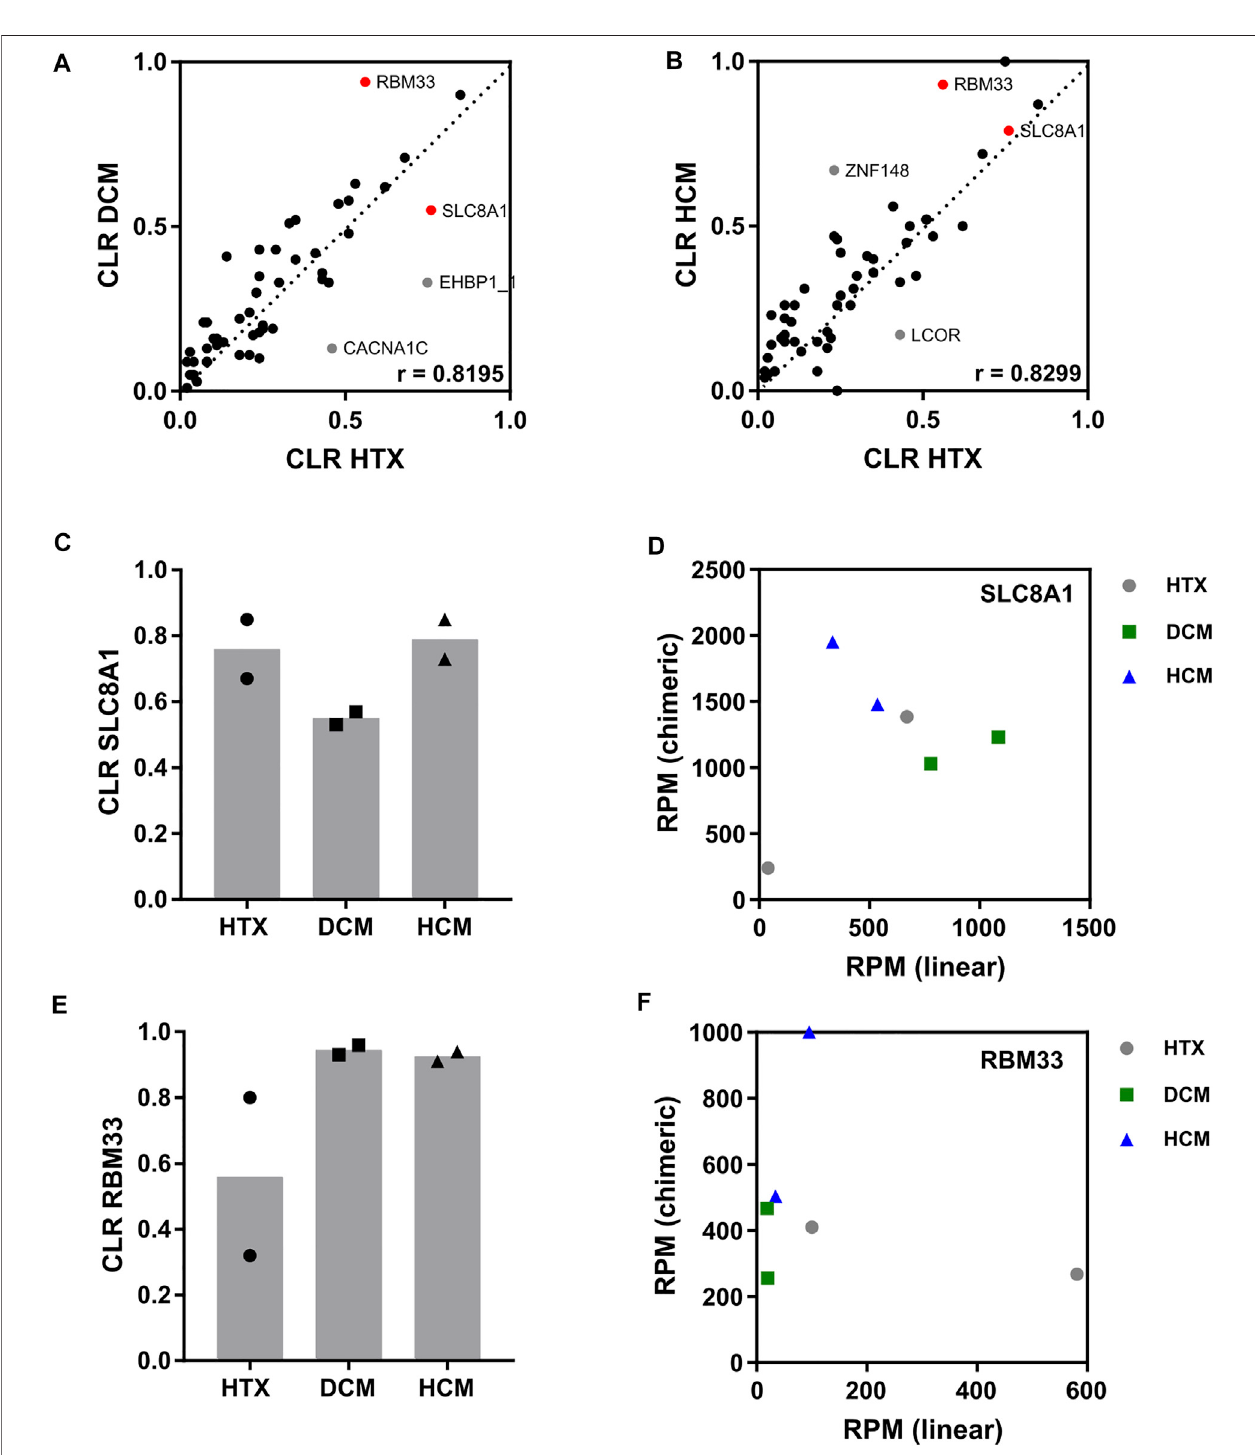
FIGURE 4 | Identi fi cation of deregulated circRNAs in cardiomyopathies. Samples from patients diagnosed with DCM, HCM, or HTX as control (two per condition) were analyzed by Lexo-circSeq. (A) Correlation of the mean CLR of HTX versus DCM. r = Pearson correlation coef fi cient. p < 0.001. Candidate deregulated circRNAs are highlighted in red. circRNAs highlighted in grey were excluded as candidates due to low expression. (B) Correlation of the mean CLR of HTX versus HCM. r = Pearson ’ s correlation coef fi cient. p < 0.001. Candidate deregulated circRNAs are highlighted in red. circRNAs highlighted in grey were excluded as candidates due to low expression. (C) CLR for SLC8A1 in HTX, DCM, and HCM samples, as indicated. (D) Analysis of SLC8A1 RPM for linear (x-axis) and chimeric (y-axis) reads in HTX,DCMandHCMsamples. (E) CLRforRBM33inHTX,DCMandHCMsamplesasindicated. (F) AnalysisofRBM33RPMforlinear(x-axis)andchimeric(y-axis)reads in HTX, DCM and HCM